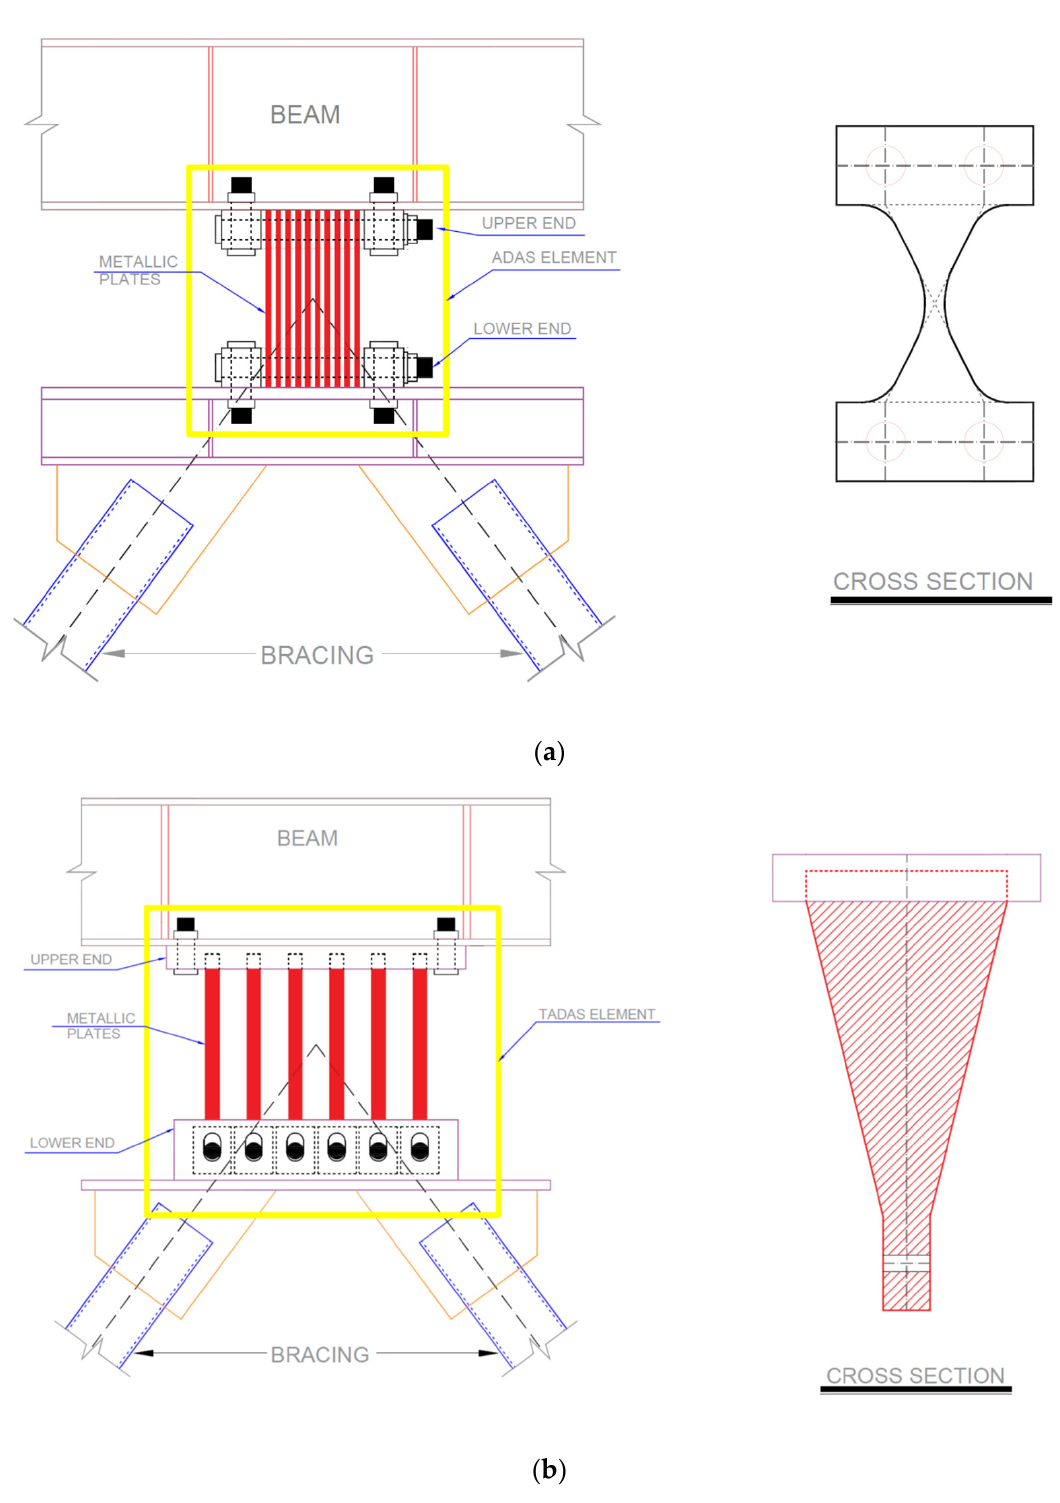
Figure 1. Configuration of ( a ) ADAS damper ( b ) TADS damper [12].